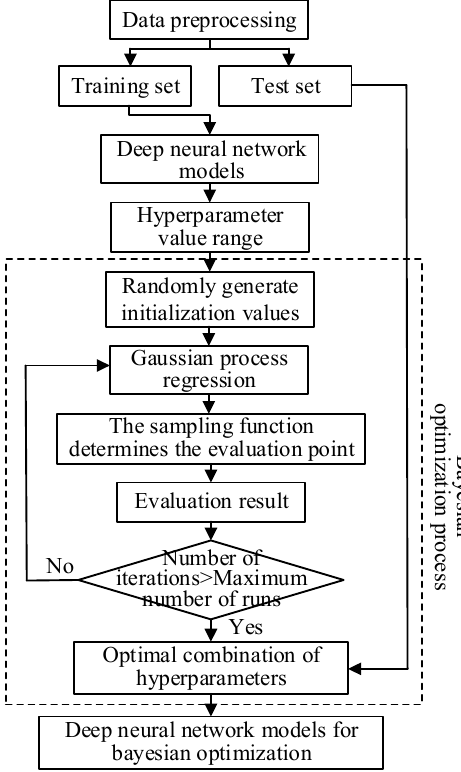
Figure 3. Bayesian optimized deep neural network model.